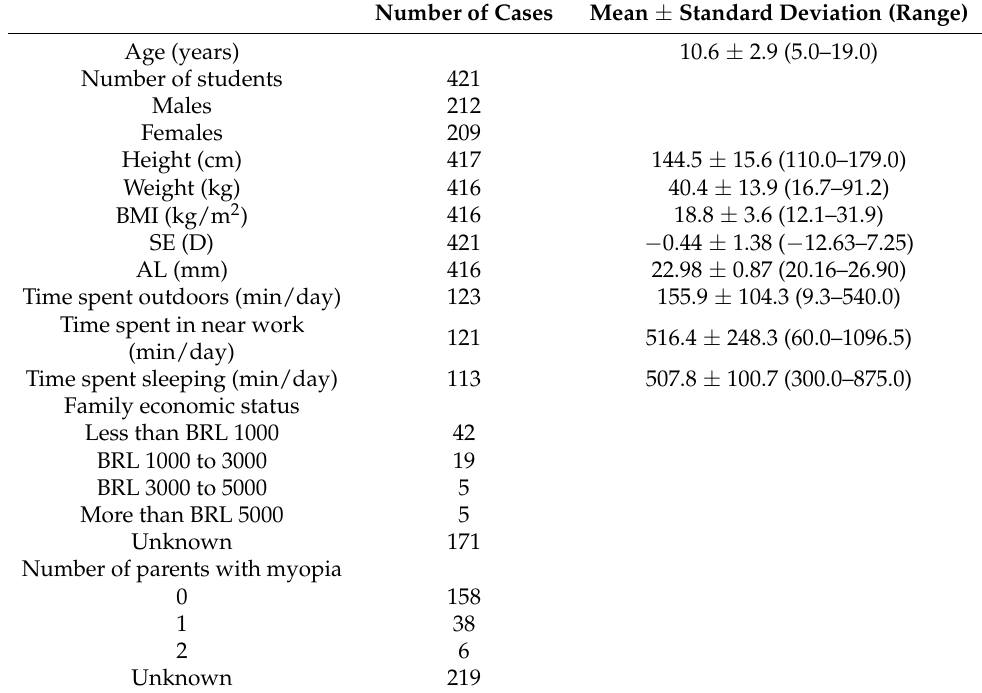
Table 1. Characteristics of the current study population and results of the questionnaire.